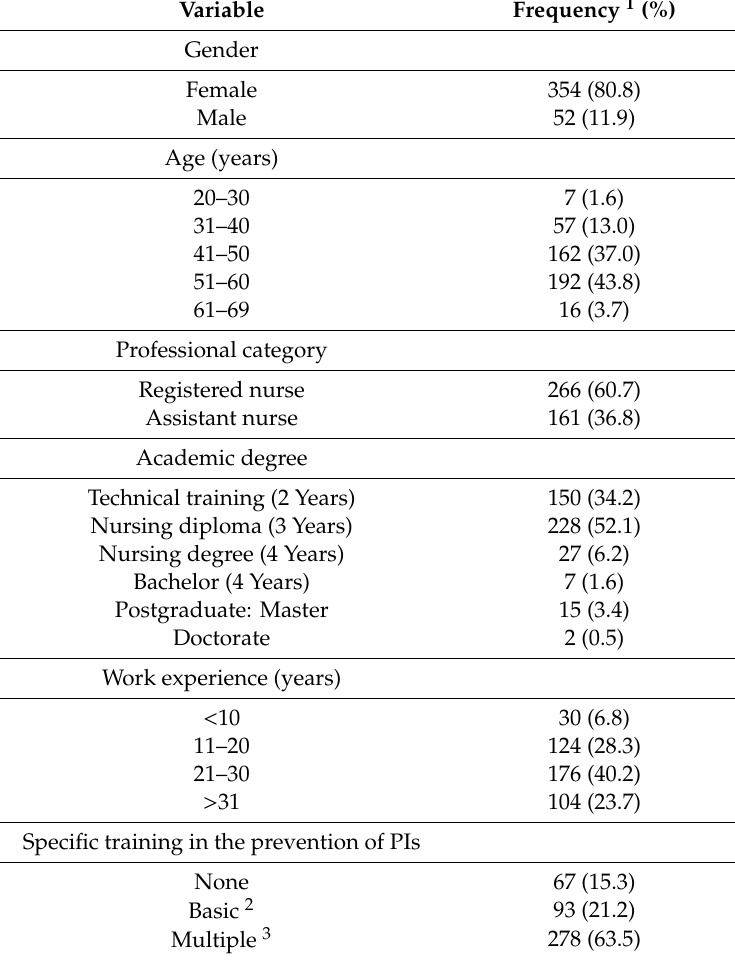
Table 2. Characteristics of Registered Nurses and Assistant